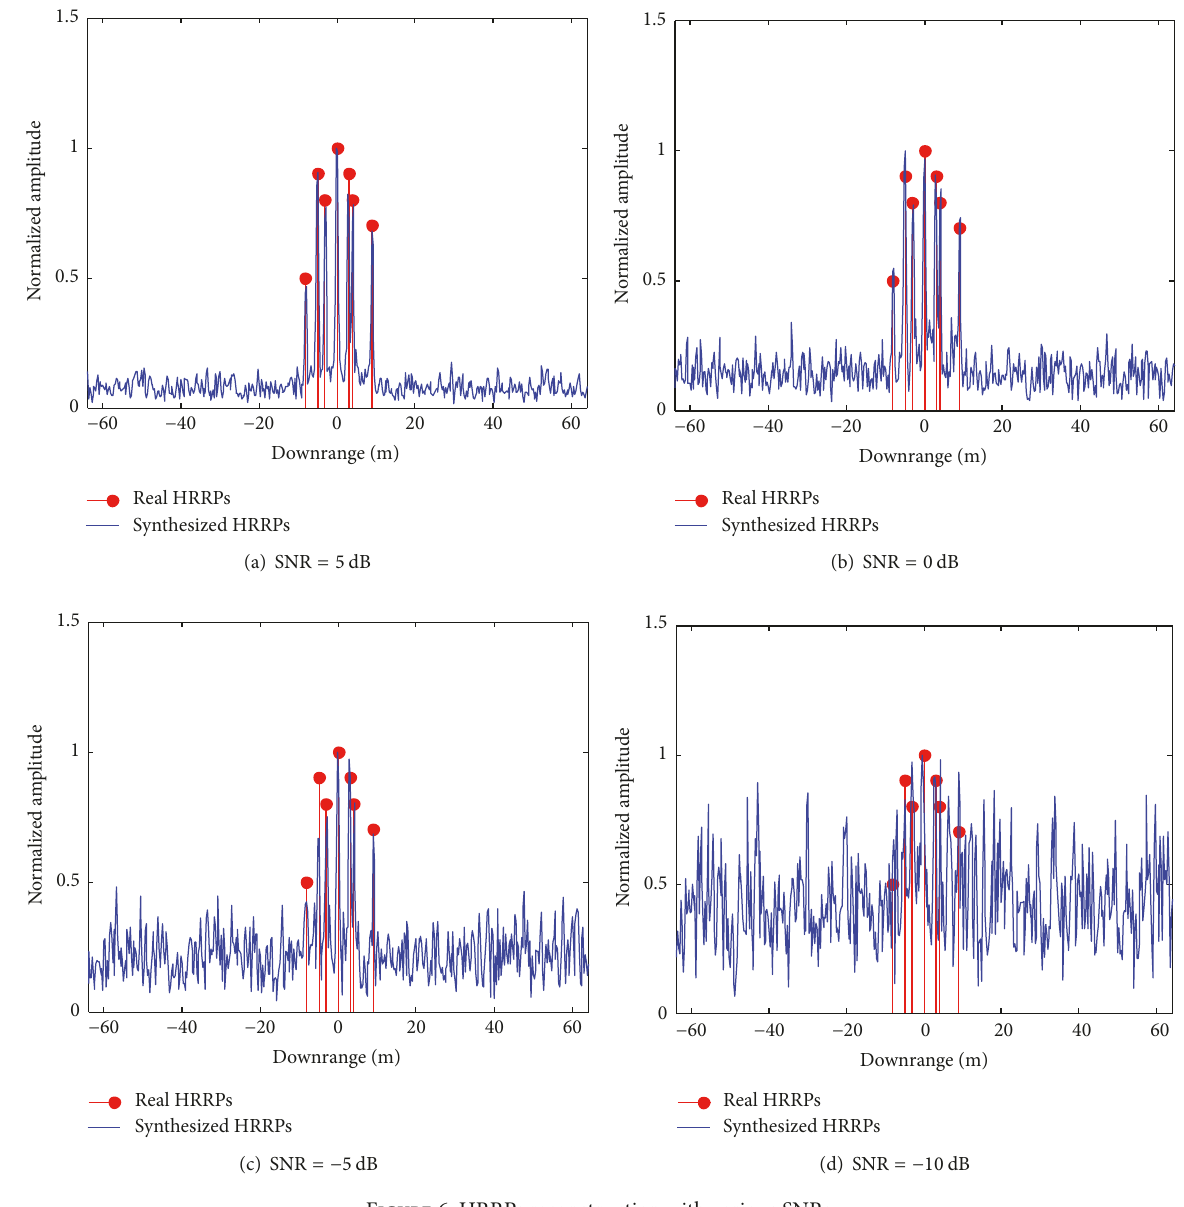
Figure 6: HRRPs reconstruction with various